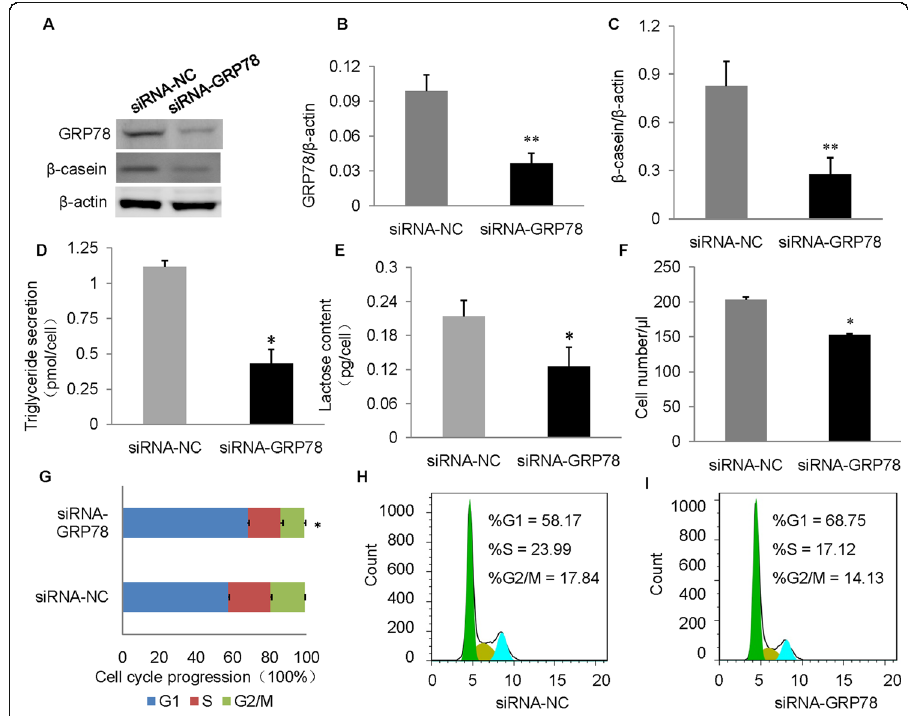
Fig. 2 RNAi of GRP78 suppresses milk biosynthesis and cell proliferation. a Western blotting analysis of GRP78 and β -casein in BMECs transfected with siRNA targeting GRP78. Cells transfected with scramble siRNA were used as a negative control (siRNA-NC). b and c Relative fold changes in protein levels (proteins/ β -actin)of GRP78 ( b ) and β -casein ( c ) determined via western blotting and quantified using grayscale scanning. d Triglyceride (TG) contents in the culture medium. e Lactose contents in the culture medium. f Cell numbers measured using a cell counter. g , h and i Cell cycle transition measured ( g ) and analyzed ( h and i ) via flow cytometry. Data represent the means ± SE from three independent experiments. * p < 0.05;** p <